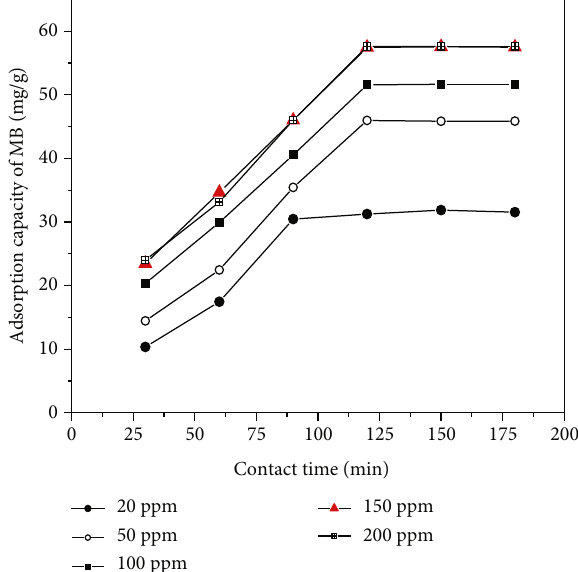
Figure 7: E ff ect of contact time on the removal of MB (pH 10, adsorbent dosage 2g, and initial dye concentration